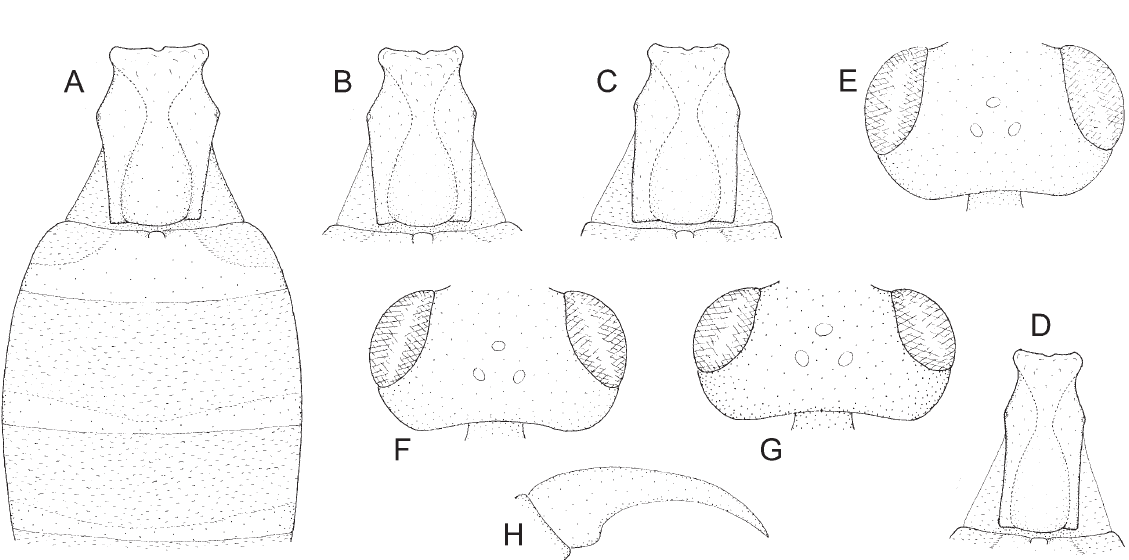
Fig. 66. — Bracon ( Osculobracon ) cingulator Szépligeti, 1901 (A, E, H: ♀ holotype, B, F: ♀, C-D, G: ♂). A . Tergites 1-4. B-D . First tergite. E-G . Head in dorsal view. H .